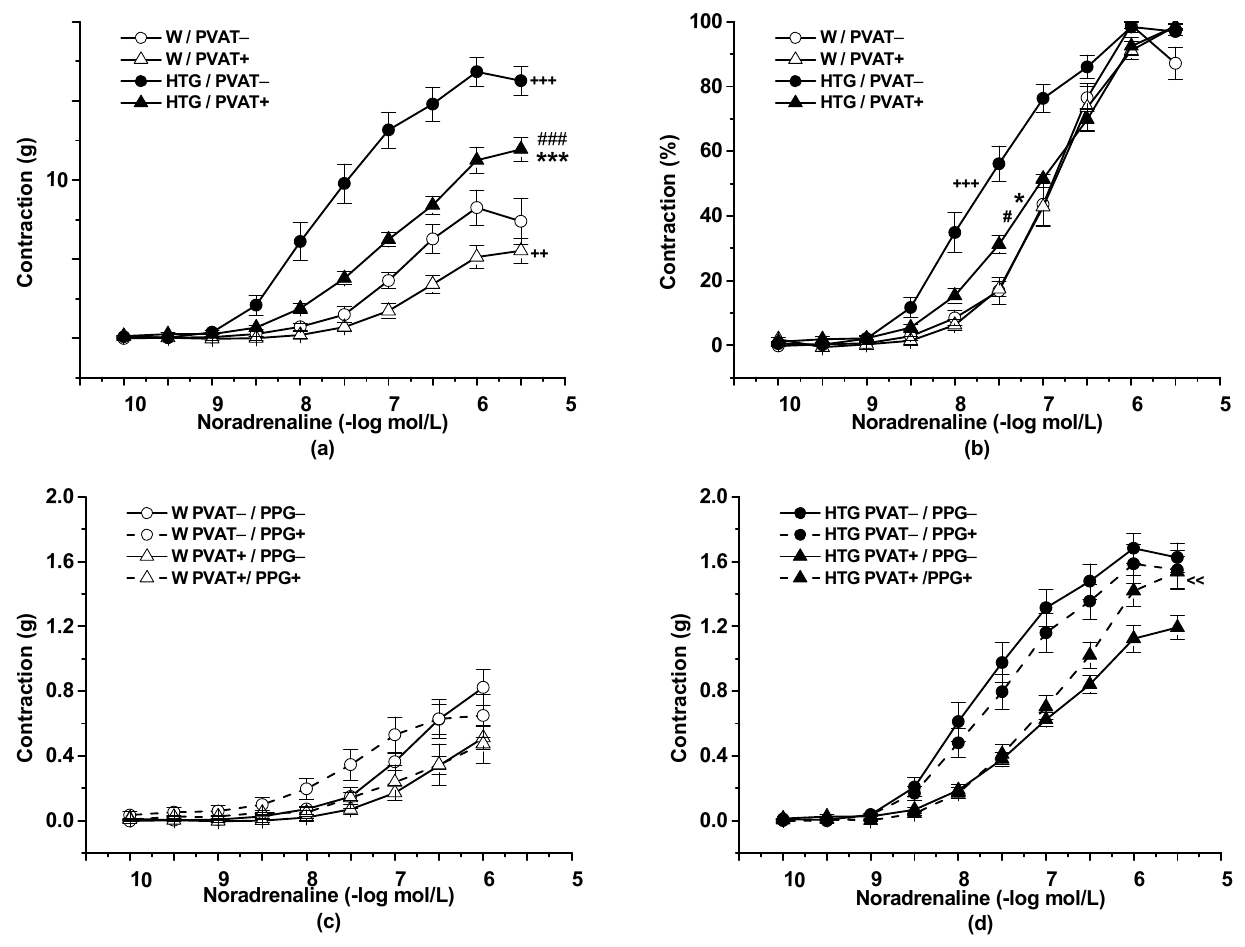
Figure 2. Noradrenaline-induced contractile response of the thoracic aorta of normotensive Wistar rats (W, n = 8) and hypertriglyceridemic rats (HTG, n = 9) with intact (PVAT+) or removed (PVAT-) perivascular adipose tissue expressed as the active wall tension ( a ) and as percentages of the maximal reached response induced by noradrenaline ( b ) before (PPG-) and after (PPG+) pretreatment with propargylglycine ( c , d ). The results are presented as the mean ± S.E.M, and differences between groups were analyzed by three-way ANOVA with the Bonferroni post hoc test on ranks. * p < 0.05 vs. W/PVAT+; *** p < 0.001 vs. W/PVAT+; +++ p < 0.001 vs. W/PVAT-; ++ p < 0.01 vs. W/PVAT-; # p < 0.001 vs. HTG/PVAT-; ### p < 0.001 vs. HTG/PVAT-; << p < 0.01 vs. HTG PVAT+/PPG-.